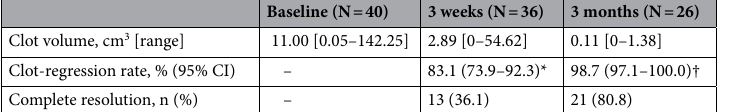
Table 2. Clot-regression effect of rivaroxaban. Clot volume, clot-regression rate and complete resolution are presented as mean (range), mean (95% CI) and number (%), respectively. CI: Confidence interval. The clot- regression rate is the ratio of clot volume regression after 3 weeks or 3 months to the clot volume at baseline. *74.7 (95% CI: 63.2–86.3) in sensitivity analysis with 4 dropouts considered to have a clot-regression rate of 0. †64.1 (95% CI: 48.9–79.4) in sensitivity analysis with 14 dropouts considered to have a clot-regression rate of 0. CI, confidence interval.